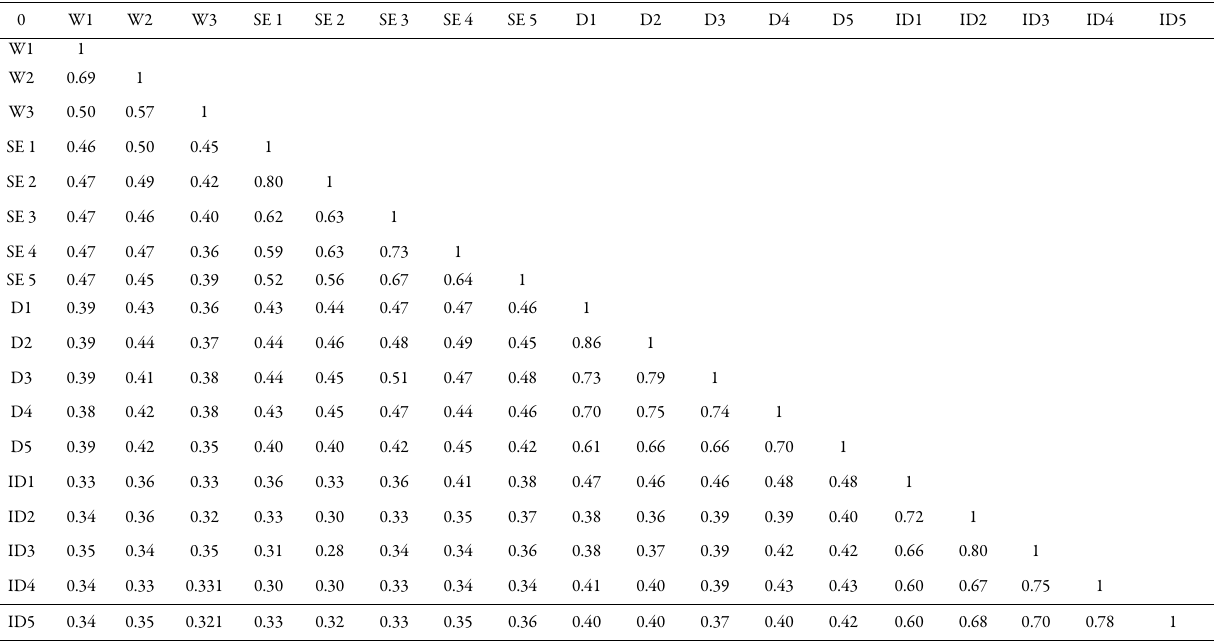
Table 4 . Jaccard’s similarity coefficient based on ISSR analysis of the in vitro regenerated plants through SE=Somatic embryogenesis, D=Direct organogenesis, ID=Indirect organogenesis and W=wild